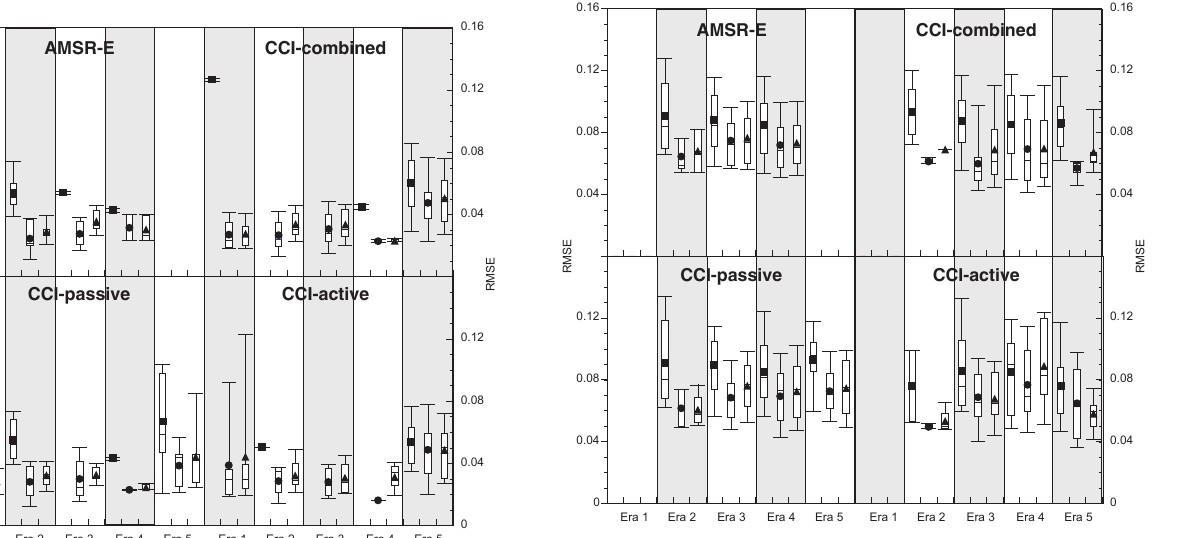
Figure 7. Box plots depicting the RMSE metric for the ARM (eras 1–4) and USCRN (era 5) networks. Symbols are the same as in Fig. 4.